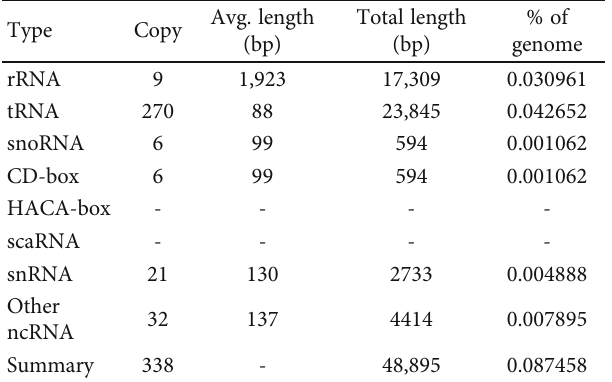
% of genome: percentage of ncRNA in